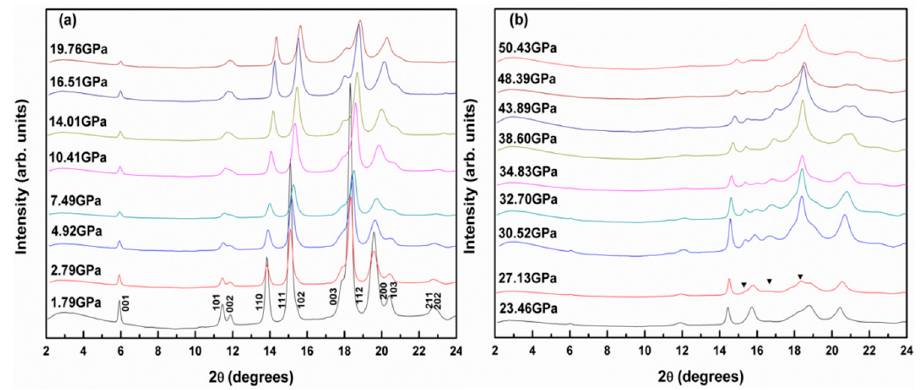
Figure 3. Synchrotron X-ray diffraction patterns of Fe 2 As polycrystalline at different pressures up to 50.43 GPa ( λ = 0.6199 Å). ( a ) XRD patterns at various pressures range from 1.79 to 19.76 GPa; ( b ) XRD patterns at various pressures range from 23.46 to 50.43 GPa, the peaks marked with inverted triangles denote the new diffraction peaks emerging.